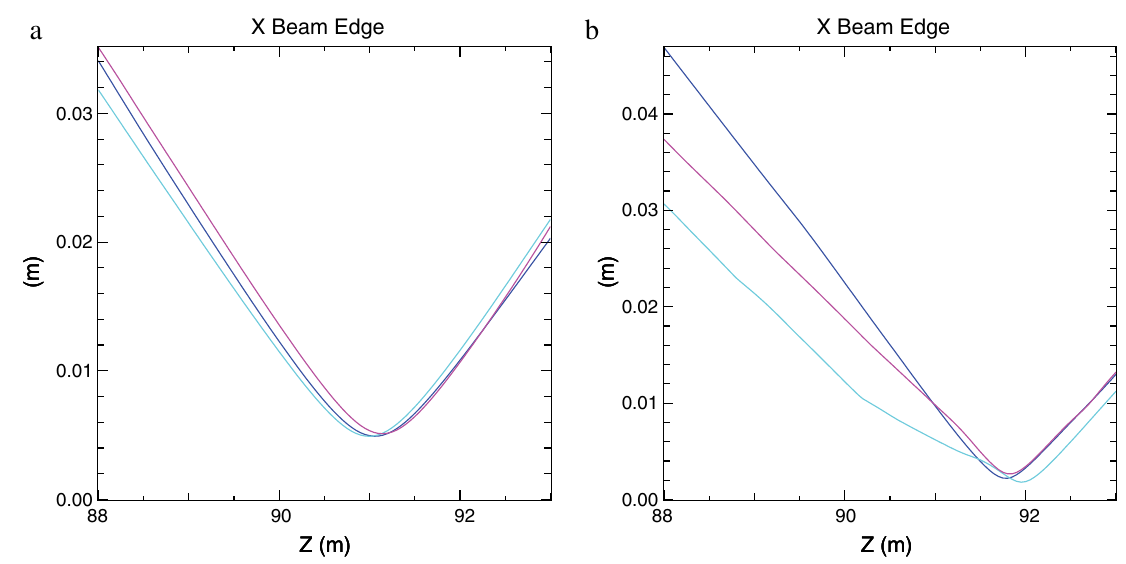
FIG. 4. Beam edge as a function of z near the focus showing a small chromatic effect: blue line corresponds to central slice; purple and cyan lines are off momentum slices near the beam tail and head, respectively. Two cases shown here are with normal emittance (a) and zero initial emittance (b).